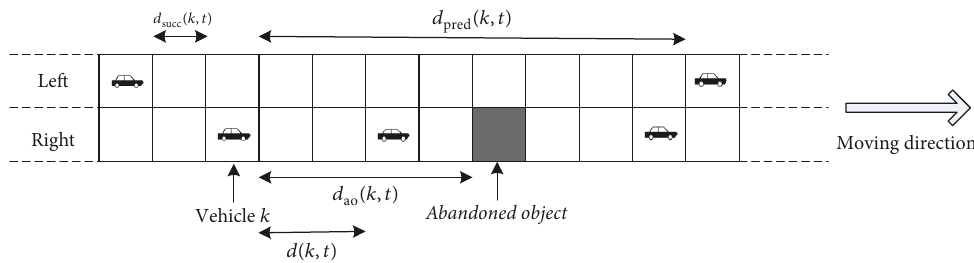
Figure 3: Positions of vehicles and the abandoned object for right lane changing rules in